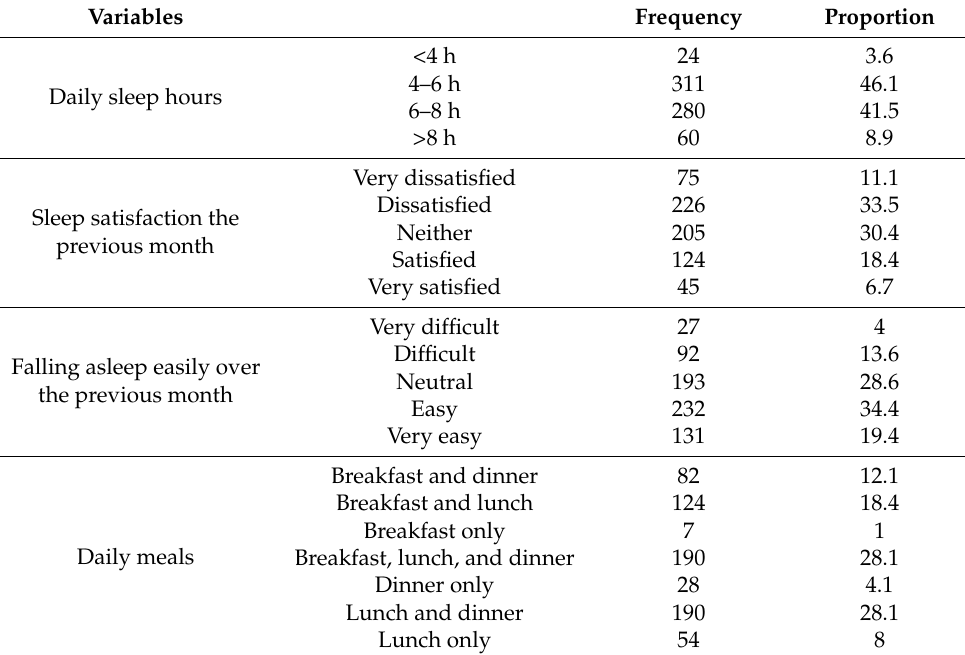
Table 2. The descriptive analysis of the medical students’ sleep, dietary, and exercise habits. N = 675.